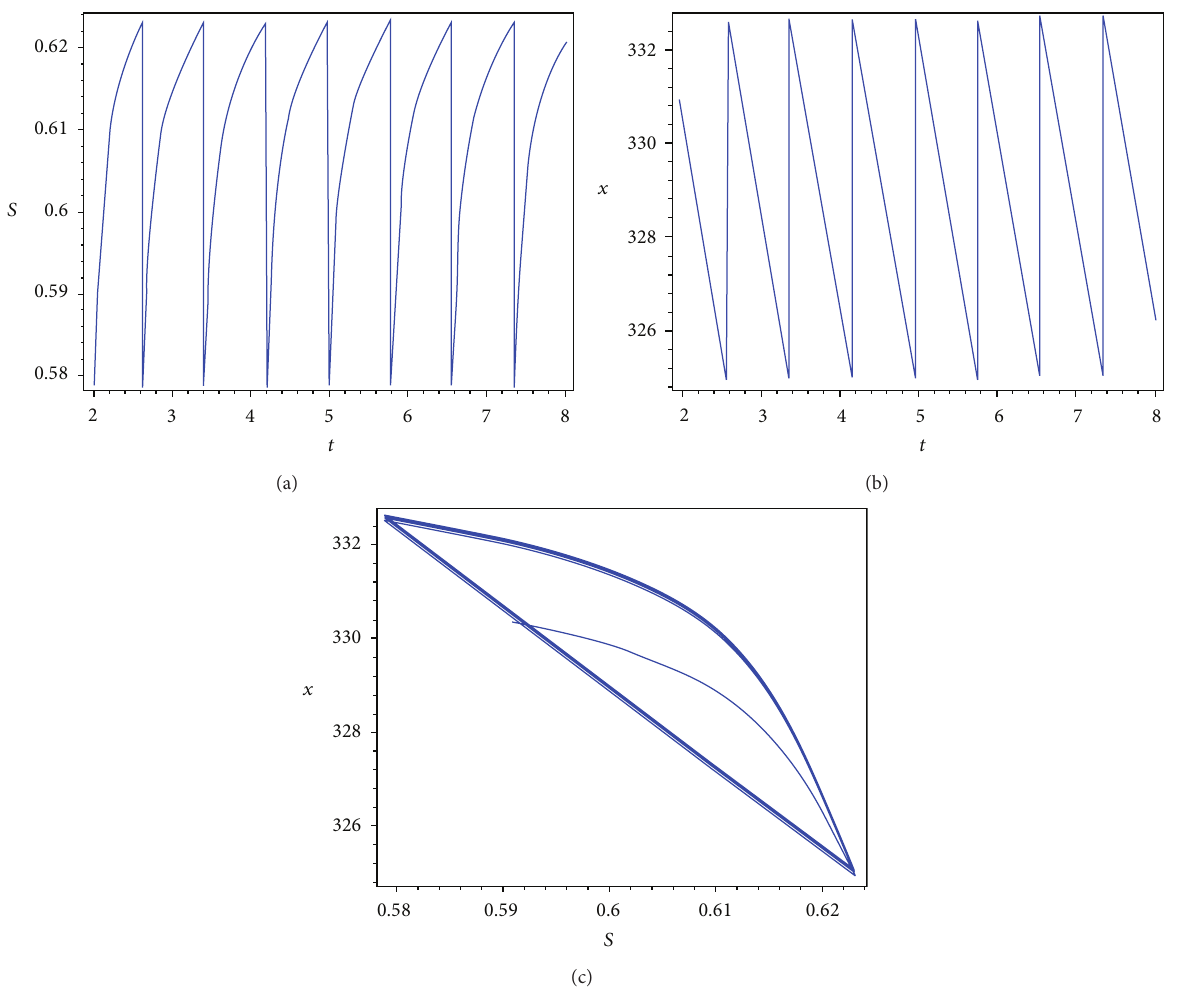
Figure 3: For ℎ ≥ 𝑘𝐷/(𝜇 − 𝐷) , the existence of order-1 periodic solution with the parameters 𝜇 = 0.4 , 𝑄 = 5 , 𝑟 = 0.02 , 𝐷 = 0.03 , 𝐸 = 0.071 , 𝜏 = 7.6 , 𝛼 = 0.2 , 𝛿 = 0.02 , and ℎ = 0.6233